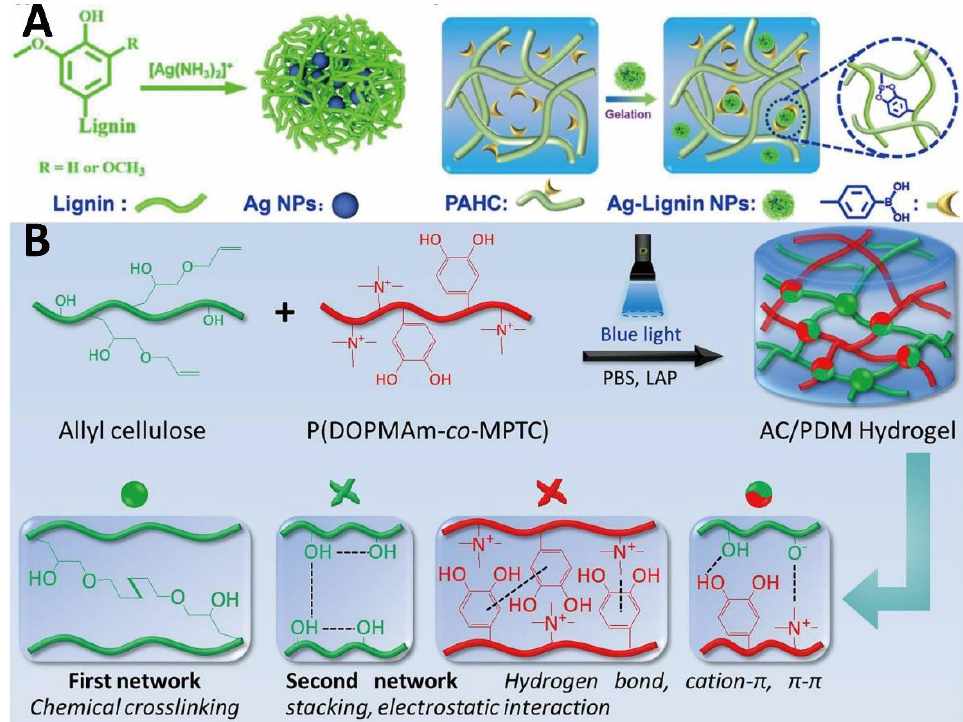
Figure 5. Cellulose-based hydrogel bio-adhesives: ( A ) formation illustration of Ag-Lignin NPs and HPC-based hydrogel bio-adhesive. Reprinted with permission from ref [99]. Copyright 2021 American Chemical Society. ( B ) Schematic of hydrogel formation under blue light and illustration of the double-network structure. Reprinted with permission from ref [100]. Copyright 2021 Elsevier.